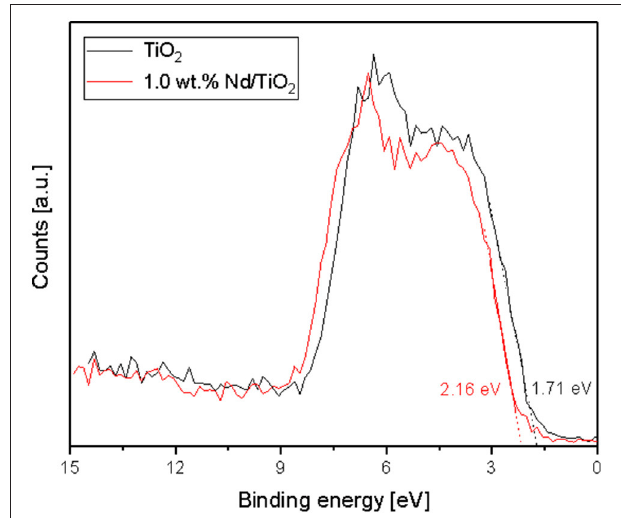
FIGURE 5 | XPS valence-band spectra of bare TiO 2 and 1.0 wt.% Nd/TiO 2